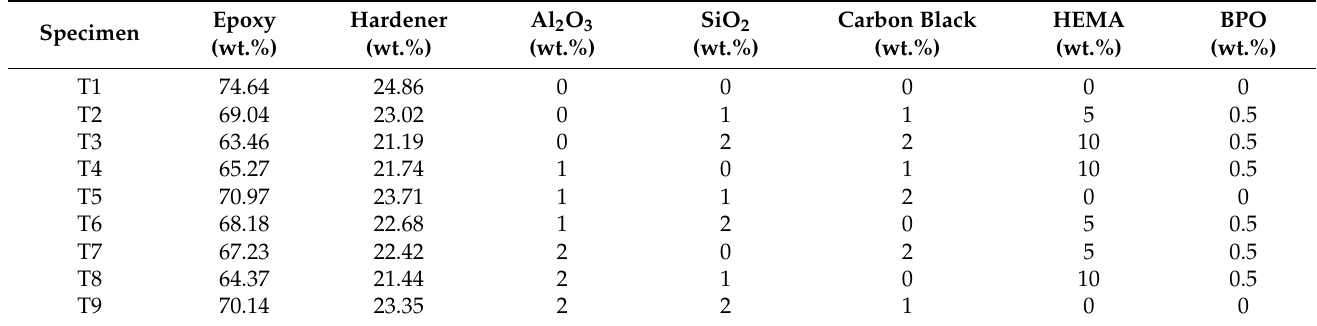
Table 2. The compositions of the specimens used in an L9 orthogonal